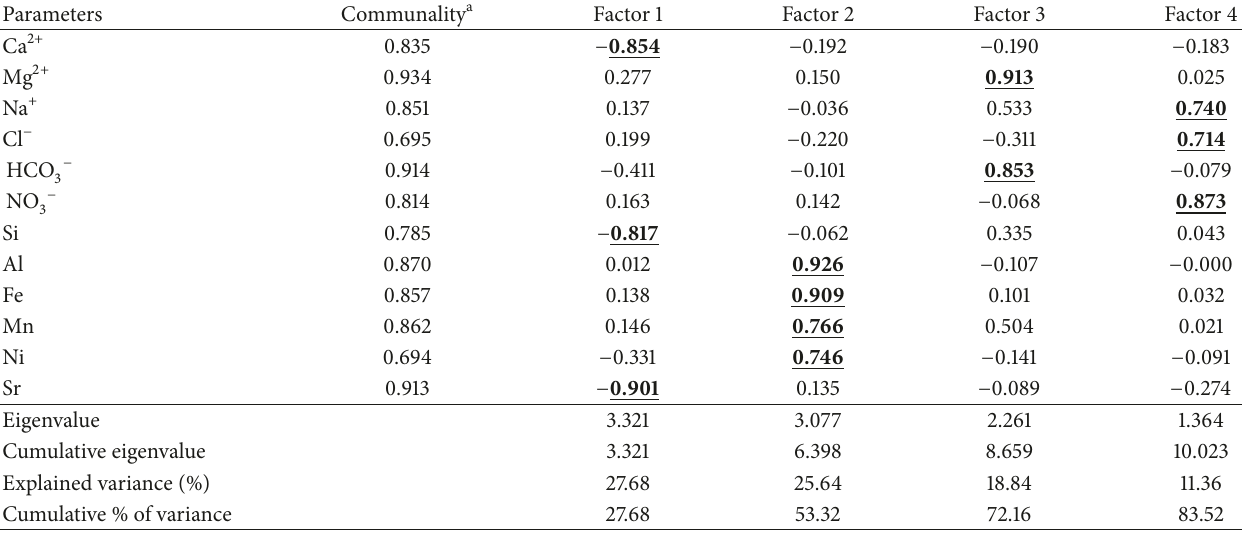
Table 4: Factor loadings for groundwater samples ( 𝑛 = 50 ) of the Kızılgedik area collected during dry and wet seasons. Significant loadings ( > 0.700) are in bold and underlined (rotation method: varimax raw; extraction method: principal